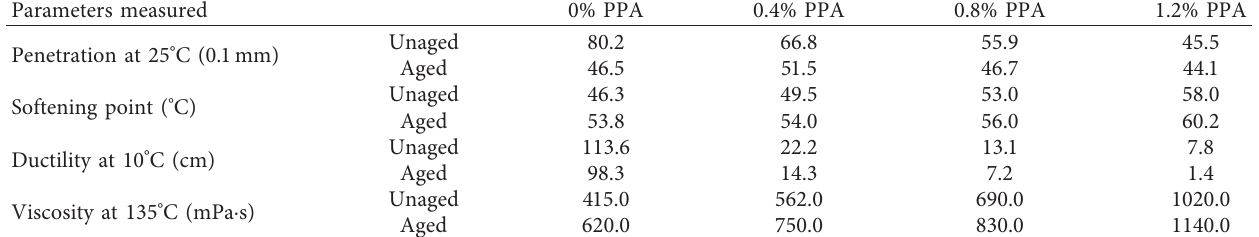
Table 4: Three indexes and viscosity of PPA-modified asphalt before and after aging. Parameters